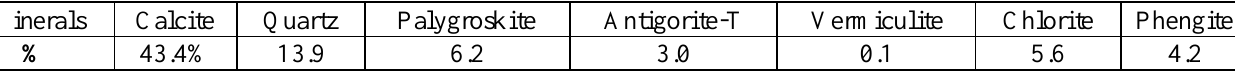
Table 3: Themineral analysis for attapulgite rock